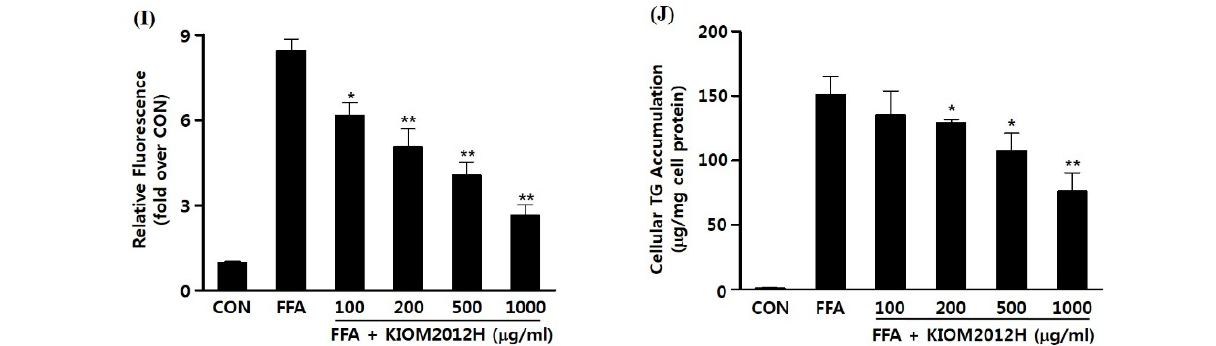
Figure 3. Inhibition of FFA-induced lipid accumulation (microscopic image), lipid contents, and triglyceride contents by KIOM2012H in HepG2 cells. Untreated ( A ); 0.1% BSA treated control ( B ); 1 mM FFA treated ( C ); and 1 mM FFA cotreated with different concentrations of KIOM2012H ( D – G ) shows dose-dependent decrease of Oil Red O stained lipid via microscope imaging (400×), and also via quantitative analysis ( H ); Intracellular